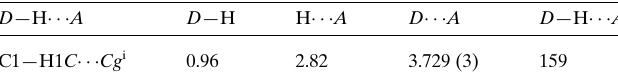
Table 2 Experimental details. Crystal data Chemical formula